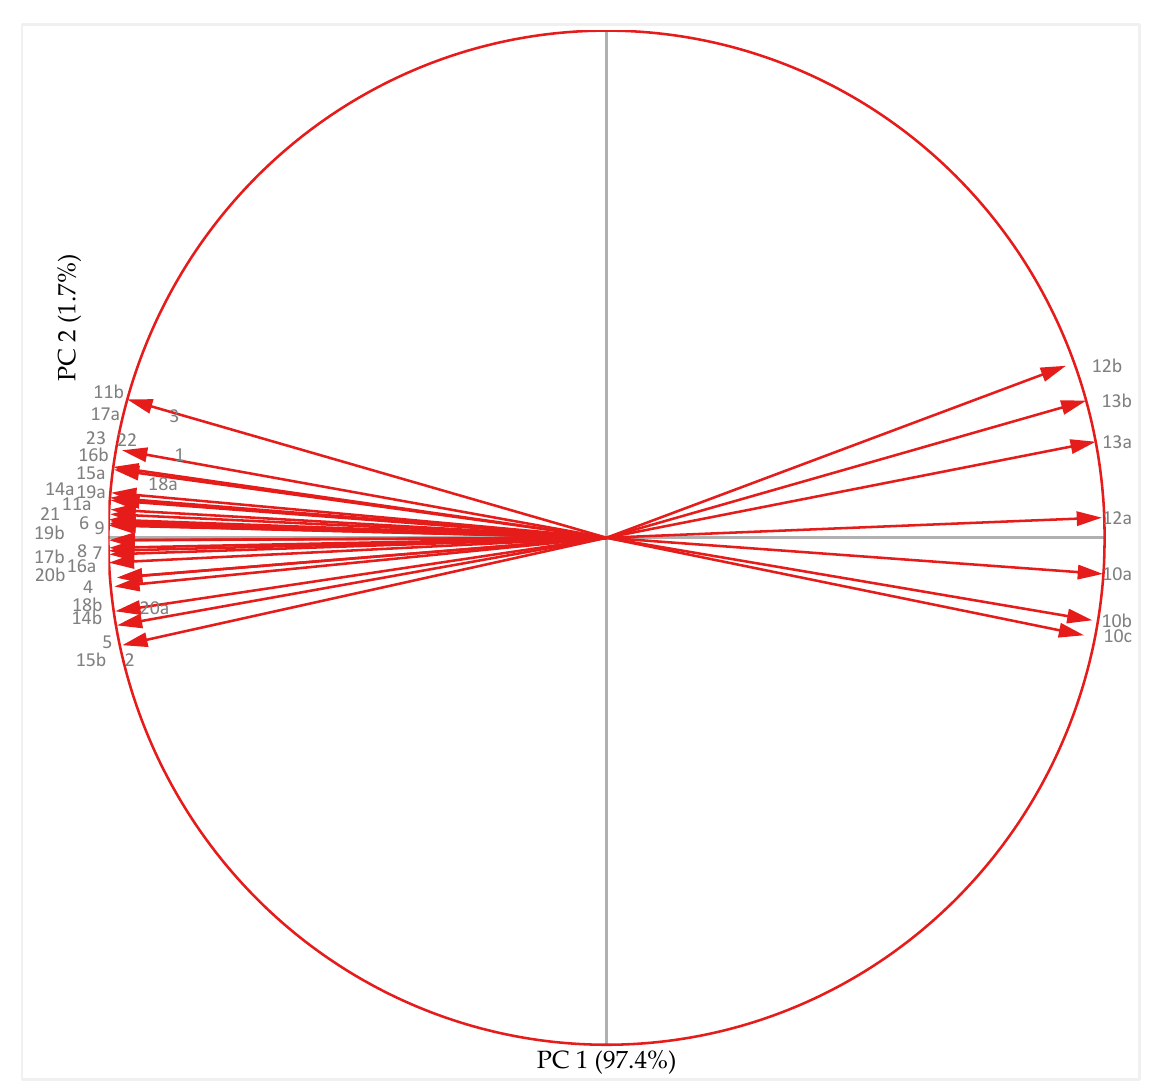
Figure 12. Principal component analysis of yield, reproductive, biochemical and leaf traits in chickpea genotypes under cold-acclimated conditions. a-anther, b-ovule; 1-RLWC-relative leaf water content; 2-SC-stomatal conductance; 3-PSII- photosynthetic efficiency; 4-Chl-chlorophyll content; 5-CAR-carotenoids; 6-PG-pollen germination; 7-PV-pollen viability; 8-SR-stigma receptivity; 9-OV-ovule viability; 10-EL-electrolyte leakage; 11-CV-cellular viability; 12-MDA-malondialdehyde; 13-H 2 O 2 -hydrogen peroxide; 14-SOD-superoxide dismutase; 15-CAT-catalsae; 16-APX-ascorbate peroxidase; 17-GR- glutathione reductase; 18-ASC-ascorbic acid; 19-GSH-glutathione; 20-proline; 21-pod set %; 22-pod number plant –1 ; 23-seed weight plant –1